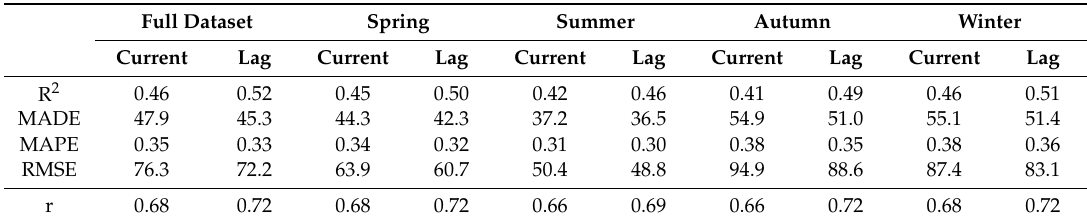
Table 5. Goodness of fit coe ffi cient for NO x modeling.